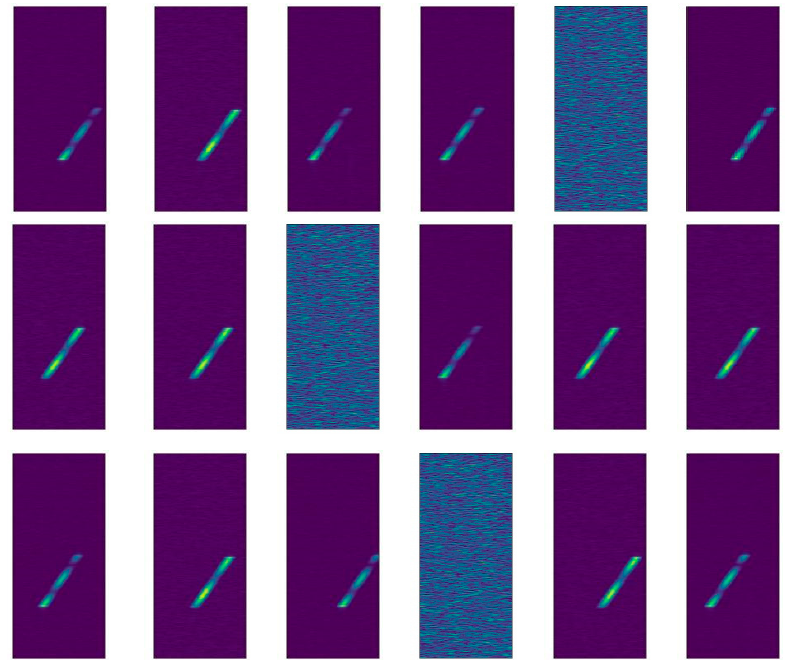
Figure 12. Partial samples of the data set. The data set contains echo signals of two different targets and ocean background noise.